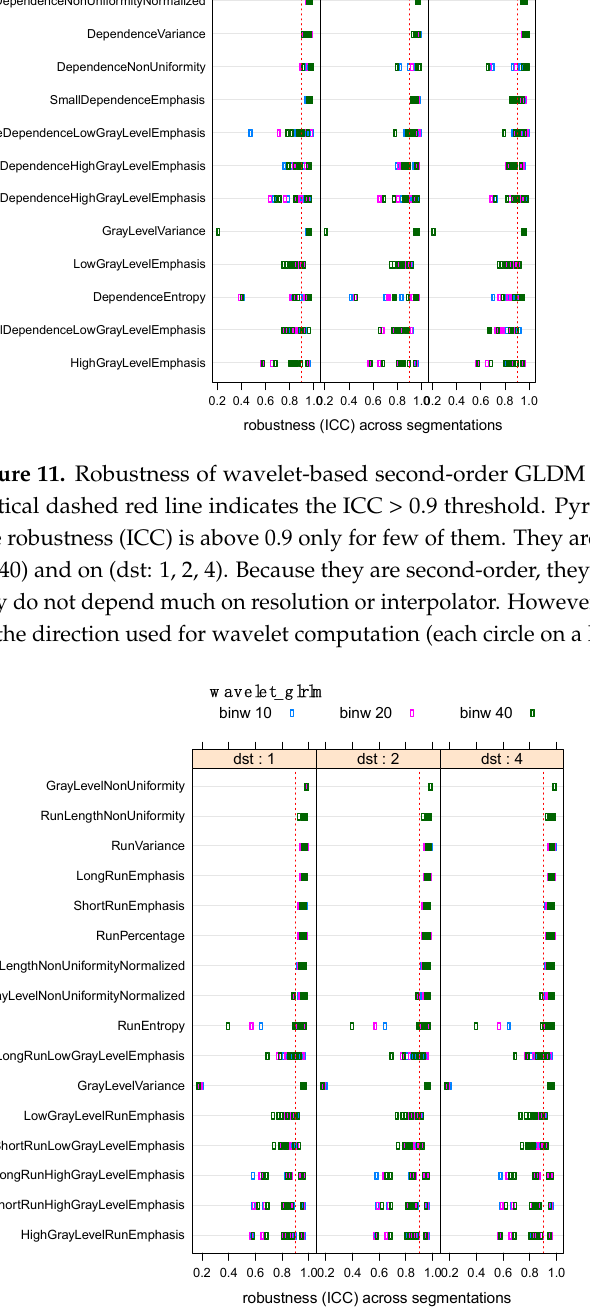
Figure 12. Robustness of wavelet-based second-order GLRLM features across segmentations. The vertical dashed red line indicates the ICC > 0.9 threshold. Pyradiomics provides 16 such features. The robustness (ICC) is above 0.9 only for few of them. They are dependent on bin-width (binw: 10, 20, 40) and on (dst: 1, 2, 4). Because they are second-order, they are dependent on distance (dst) but they do not depend much on resolution or interpolator. However, the wavelet features are dependent on the direction used for wavelet computation (each circle on a line is a different gradient